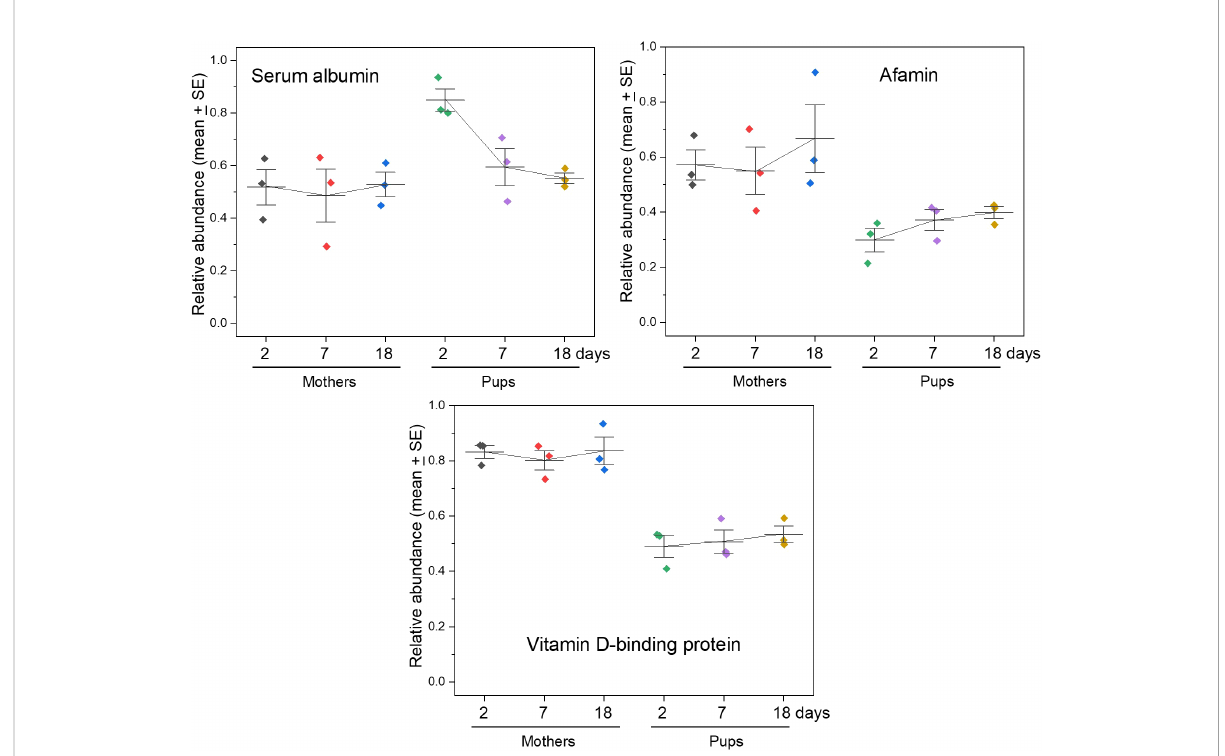
FIGURE 4 Albumin and related proteins. Serum albumin is the most abundant protein in the plasma of mammals and carries fatty acids, other lipids, and a range of other compounds and mineral ions. Afamin and vitamin D-binding protein are evolutionarily related to serum albumin, and each are known to bind lipids, though less is known about them, afamin in particular. Alpha foetoprotein is also in the albumin family, is considered to perform a similar role to albumin in the foetus, is usually found in the serum of mothers and offspring for a period after birth, but was not detected by our proteomic analysis in these grey seal